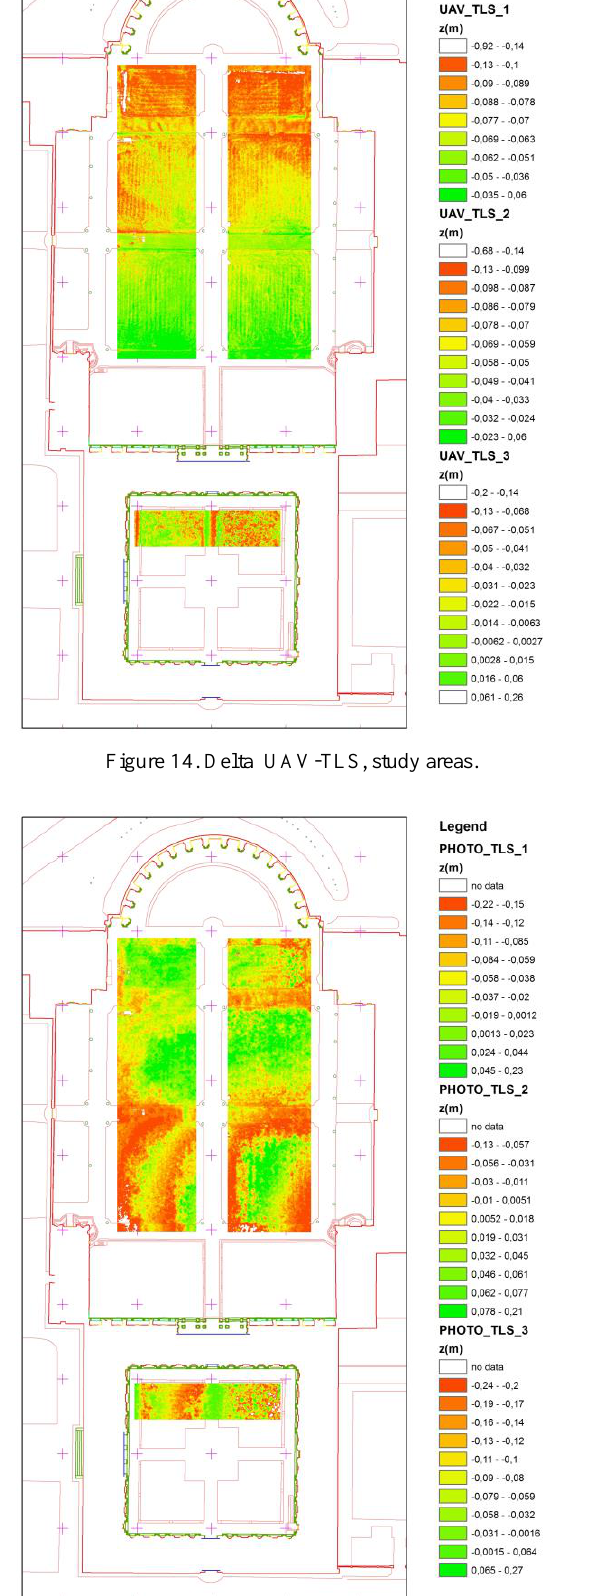
Figure 9. Planimetry of the